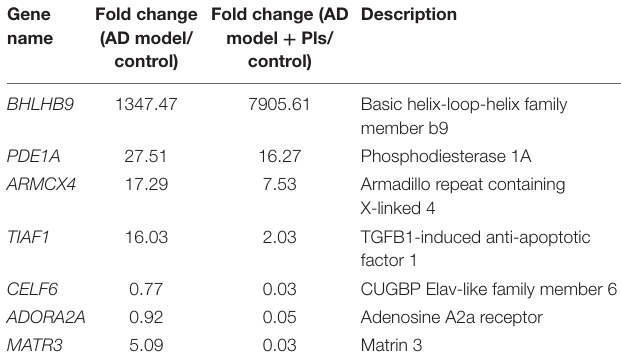
TABLE 5 | Other DEGs identified among different